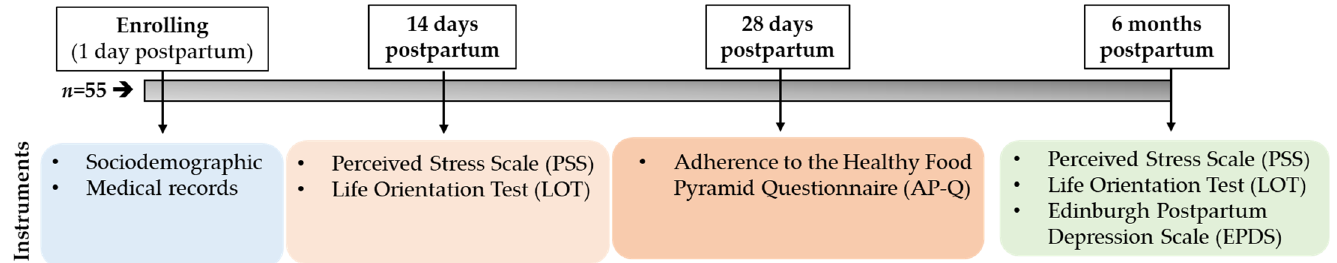
Figure 1. Diagram of the study design and time point.